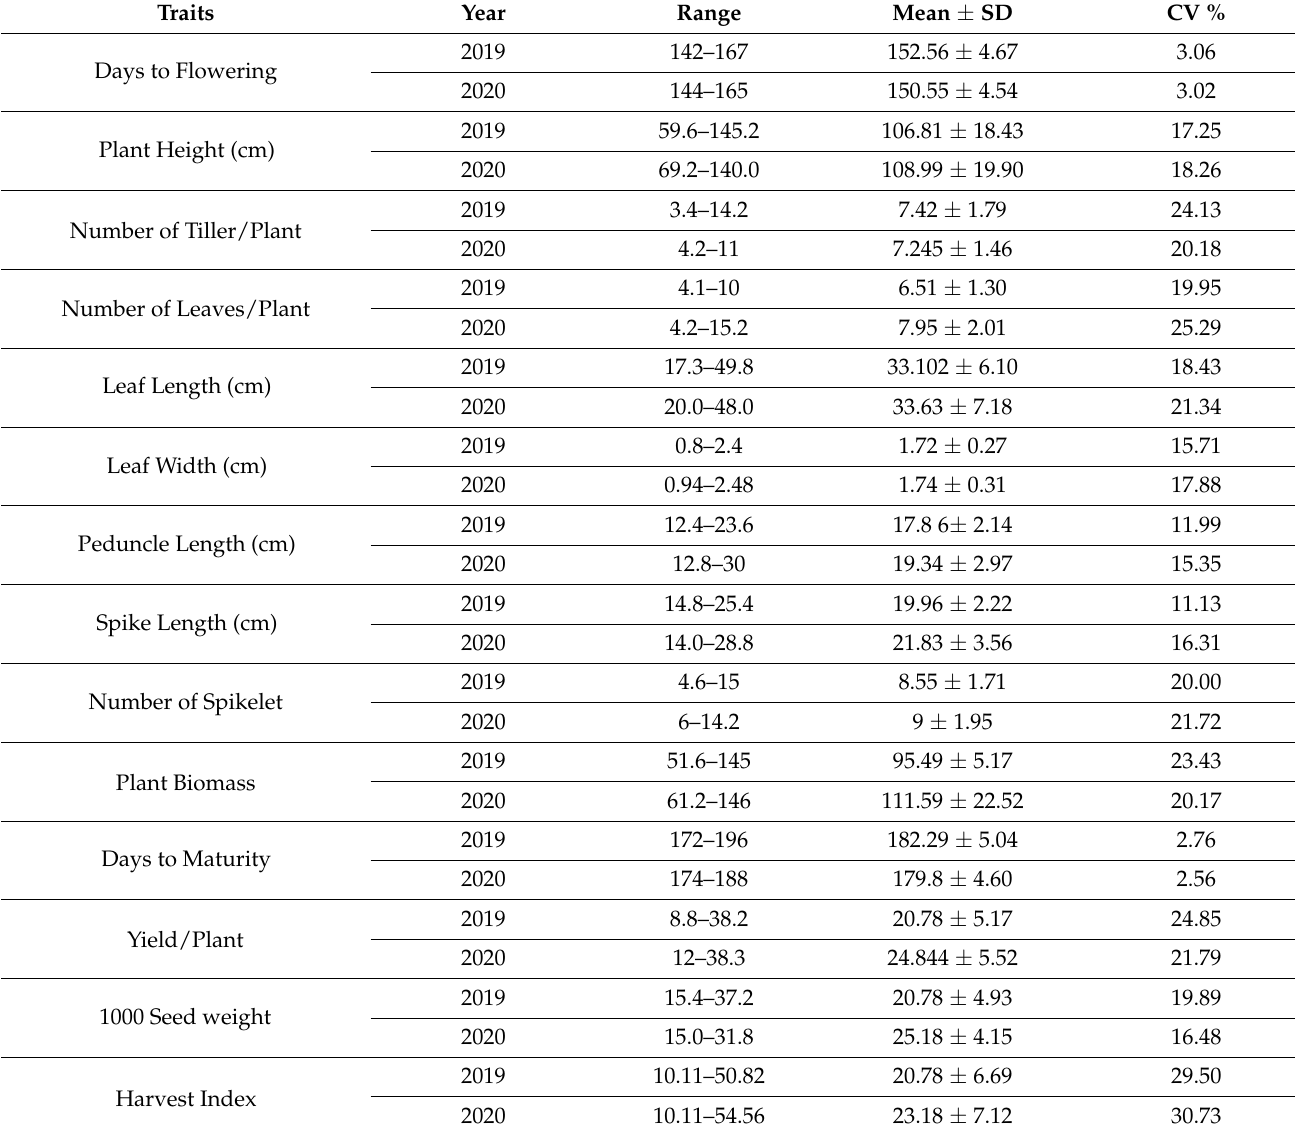
Table 1. Range, mean, standard deviation and C.V% of 14 quantitative traits of Oat ( Avena sativa ) genotypes.